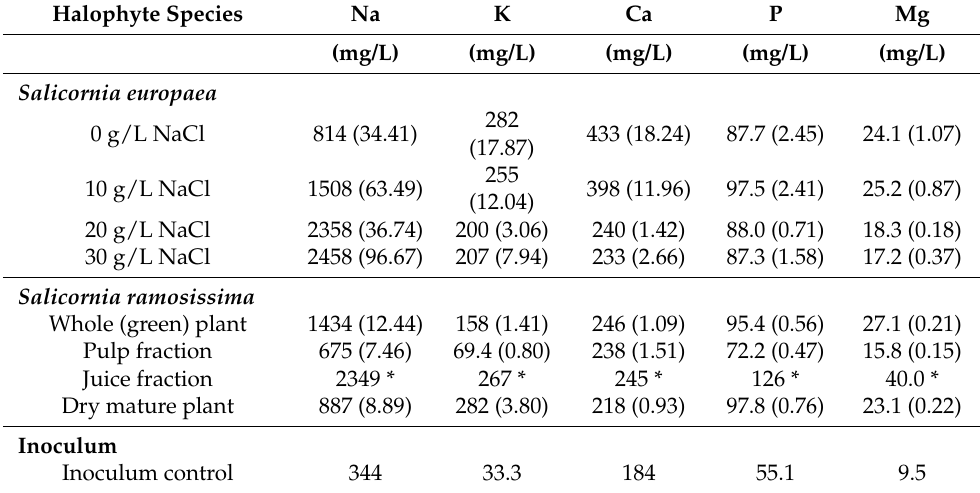
Table 6. Mineral concentration in the BMP batch test set-up of mixtures of Salicornia samples and inoculum in